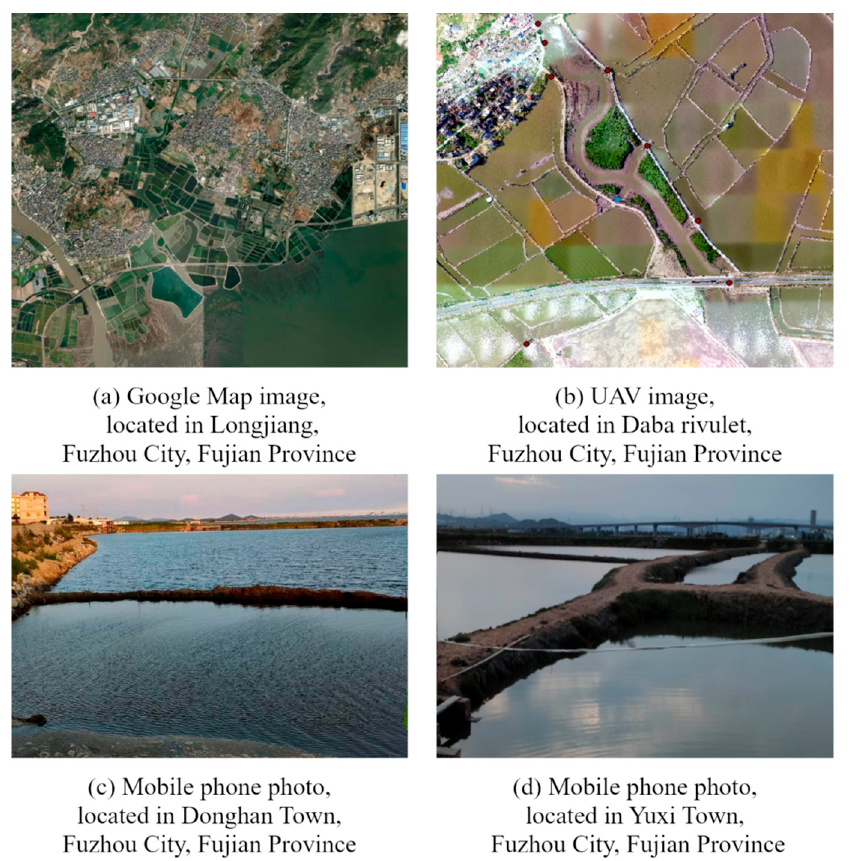
Figure 2. Objects of an aquaculture pond in remote sensing images and in situ photos.